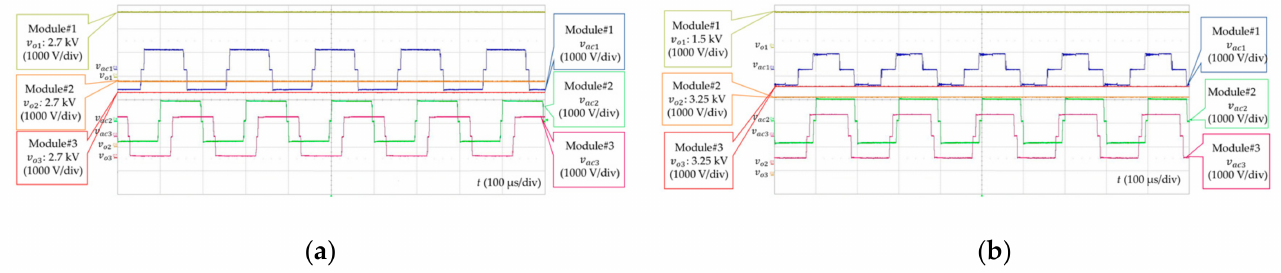
Figure 24. Operating characteristics when PV power changes. ( a ) Three PV simulators output the same power; ( b ) The power of PV Simulator#1 is reduced.